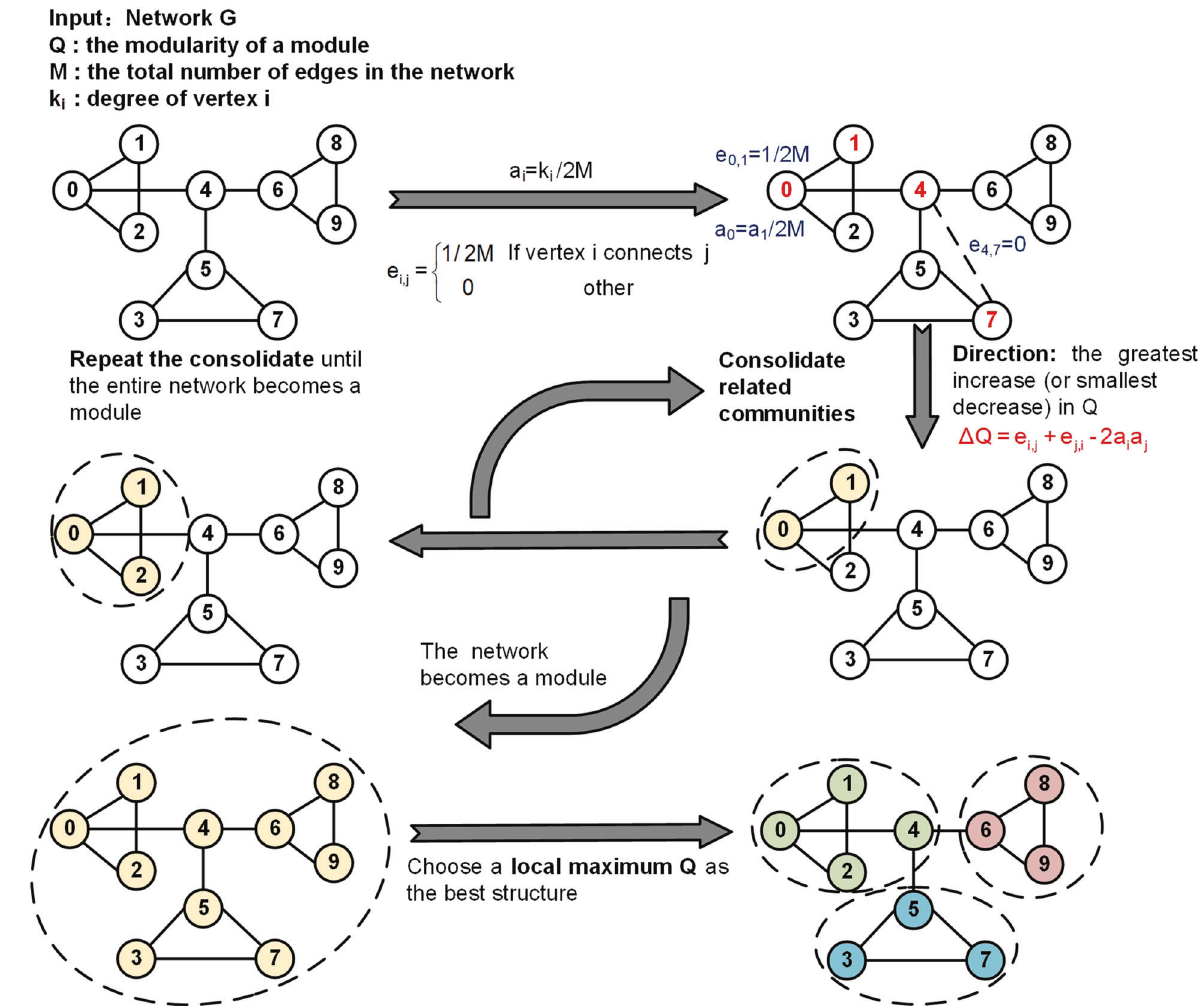
Fig. 4 The fl ow chart of the module detection